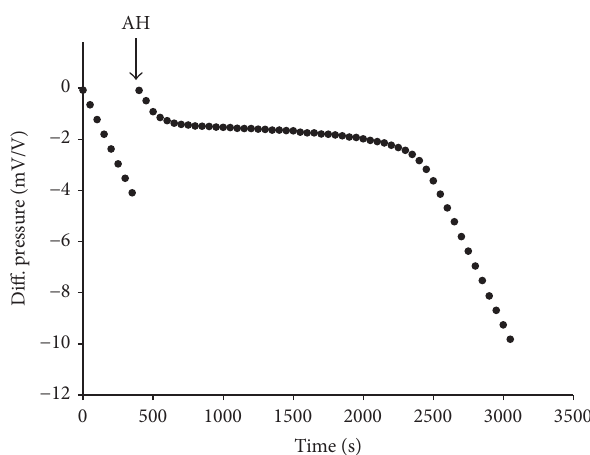
Figure 3: Differential pressure profile measured during the autoxi- dation of styrene inhibited by PMHC at 30 ∘ C in chlorobenzene. The arrow indicates the injection of the antioxidant. Reaction conditions were styrene 4.3M; AIBN 0.05 M, PMHC: 5.0 𝜇